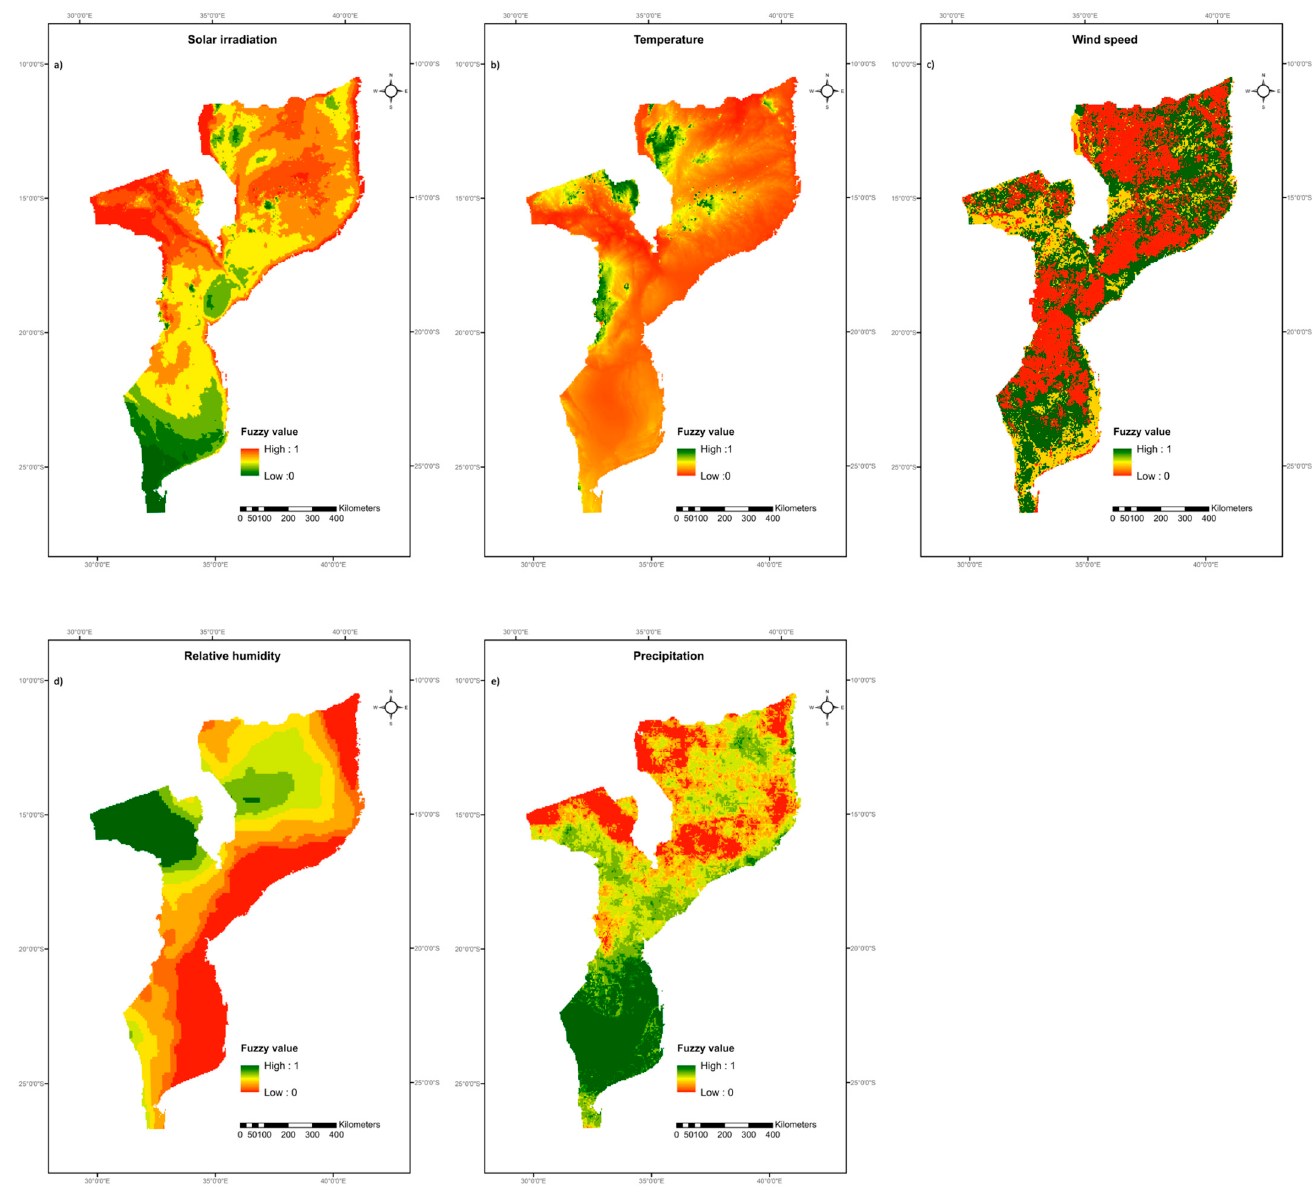
Figure A3. Standardized (reclassified and fuzzified) raster maps of climatology criteria applied to the spatial suitability of off-grid solar PV microgrid projects in Mozambique. ( a ) Solar irradiation, ( b ) temperature, ( c ) wind speed, ( d ) relative humidity, and ( e ) precipitation.